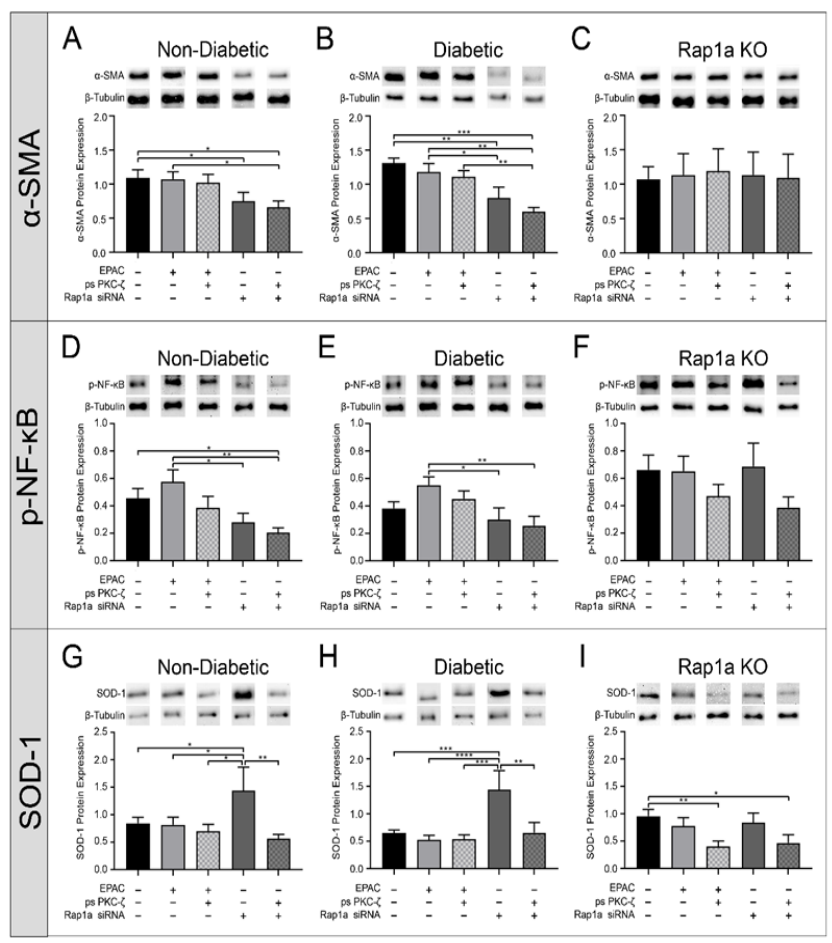
Figure 9. Inhibition of p-PKC-ζ caused a decreased in RAGE associated proteins which was further attenuated with Rap1a siRNA treatment. Cardiac fibroblasts were isolated from non-diabetic, diabetic, and Rap1a KO mice. Cells were treated either with EPAC (100 µM), EPAC + ps PKC-ζ (100 µM and 1 µg/mL, respectively), Rap1a siRNA (100 nM), or Rap1a siRNA + ps PKC-ζ (100 nM and 1 µg/mL, respectively), followed by collection of total protein. ( A – C ) α-SMA (42 kDa), ( D – F ) p-NF-κB (65 kDa), and ( G – I ) SOD-1 (23 kDa) protein expression was assessed. Protein expression was normalized to β-tubulin (55 kDa) protein expression and mean ± SEM were depicted in graph (n = 6–9). Representative western blot images are shown above graphs but are not displayed as a continuous blot due to running order on the blot not aligning with graphical order of samples. However, original western blot images are available at DOI:10.6084/m9.figshare.12625409. Data depicted for EPAC and Rap1a siRNA treatment groups were previously presented Figures 3–5. Significance was